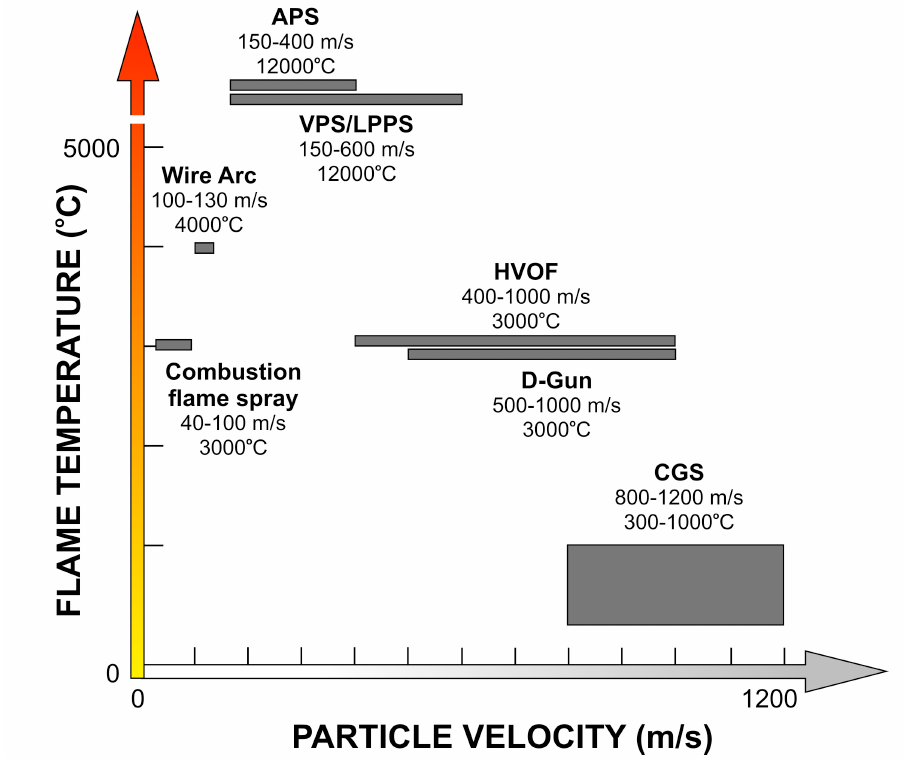
Figure 1. Typical flame temperature and particle velocity operation ranges for various thermal spray